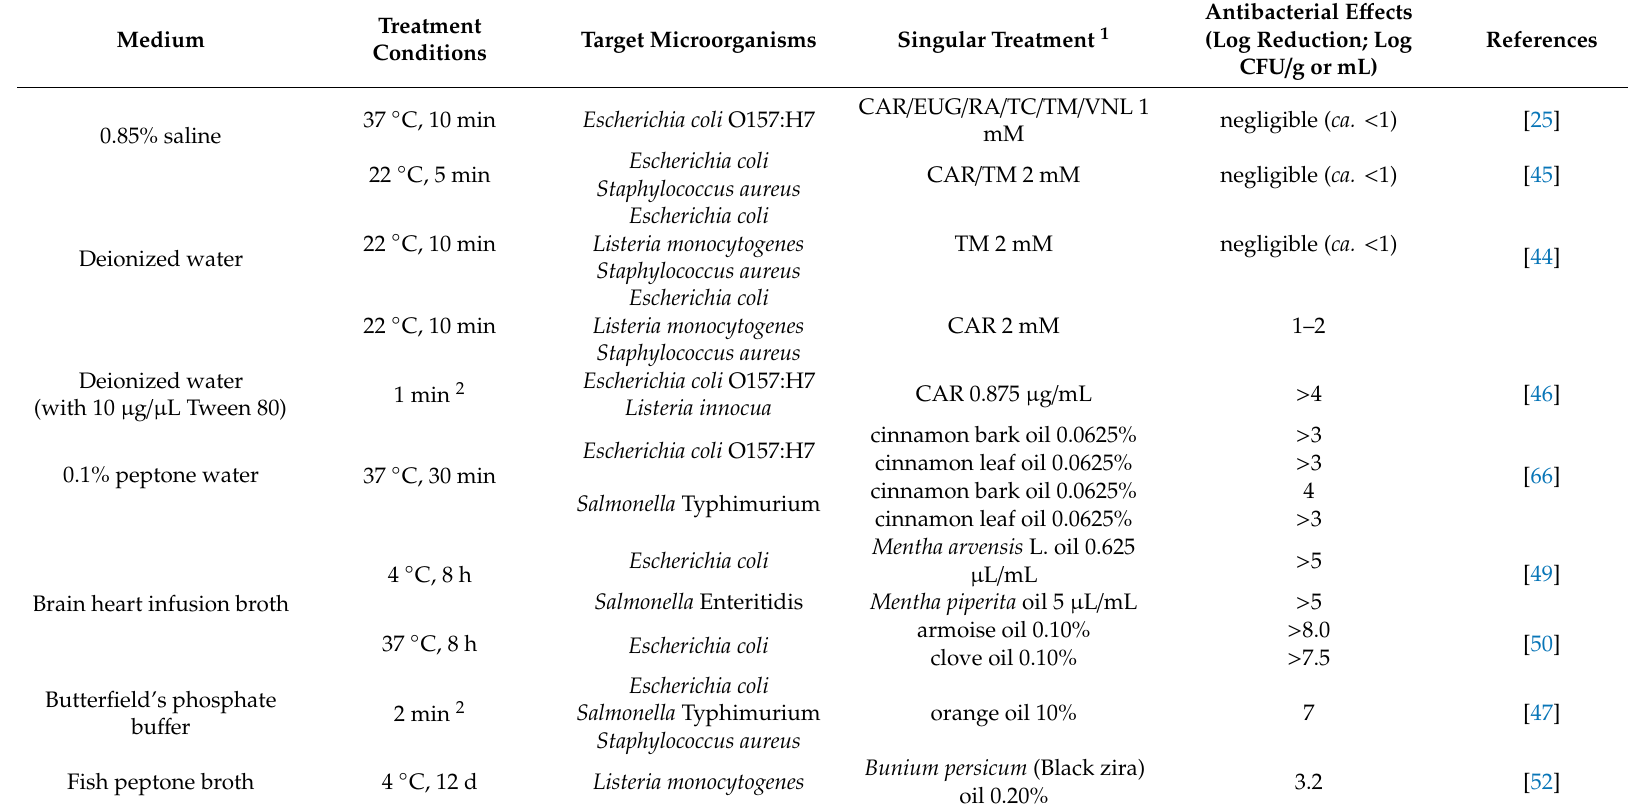
Table 3. Antimicrobial e ffi cacy of singular treatment of essential oils in microbial